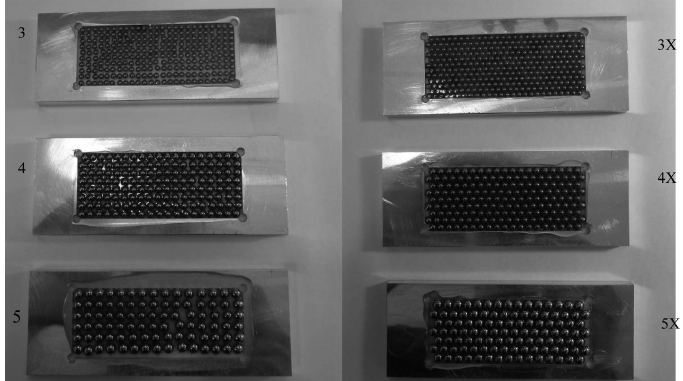
Fig. 61. EIDL Specimens.